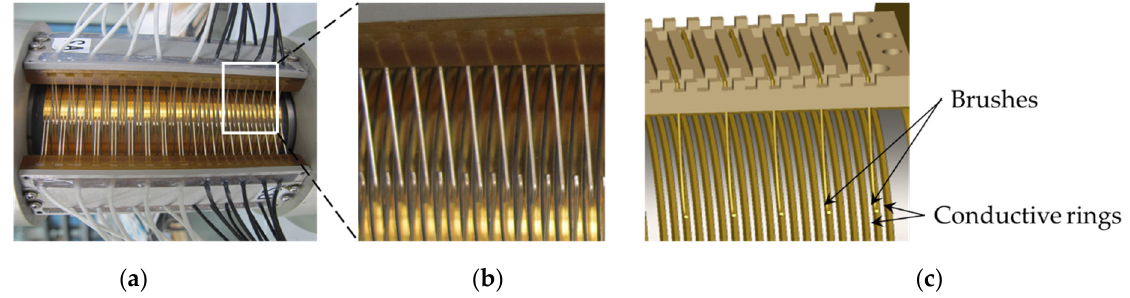
Figure 1. Conductive slip ring: ( a ) SADA slip ring; ( b ) Enlarged view of ( a ); ( c ) Design model of slip ring.